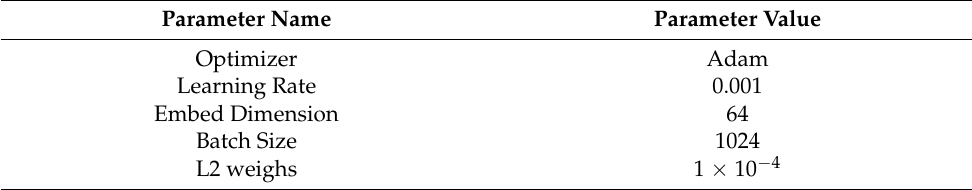
Table 2. Experimental